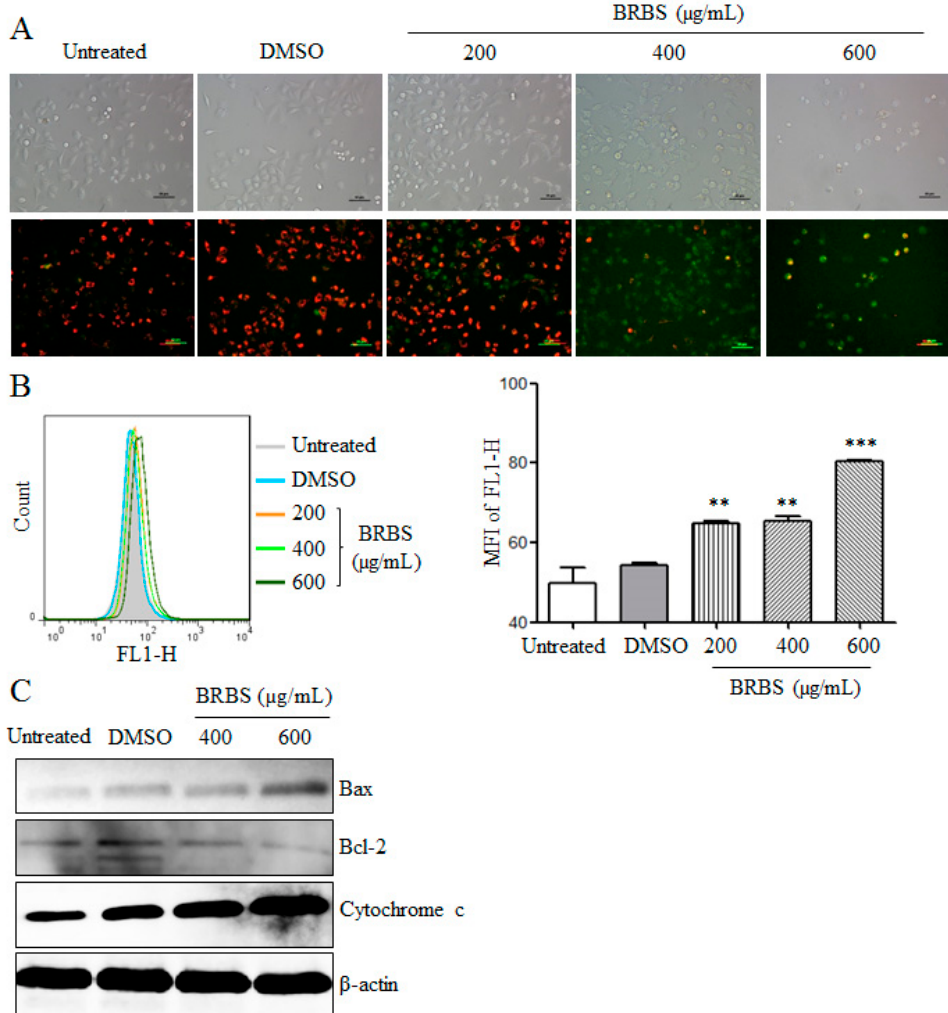
Figure 4. BRBS reduces the mitochondrial membrane potential (MMP) of A549 cells. Cells were treated with BRBS for 24 h and stained with JC-1. Samples were analyzed by inverted fluorescence microscope (Scale bar = 50 µm) ( A ) and flow cytometry ( B ). ** p < 0.01; *** p < 0.001 compared to Untreated. ( C ) Protein samples of A549 cells were prepared and the levels of Bax, Bcl-2 and cytochrome c were measured by Western blot.